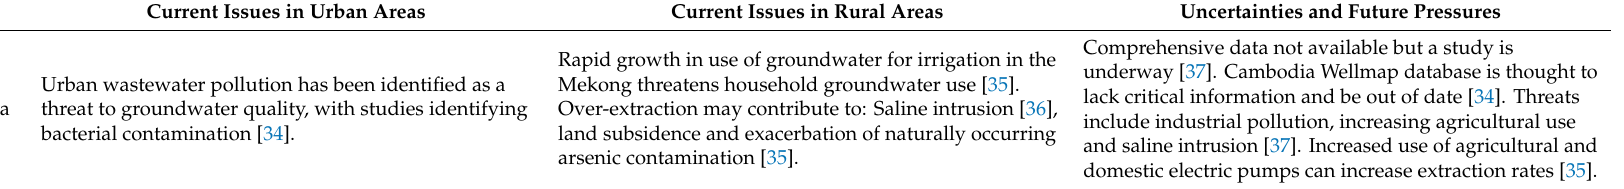
Table 2. Synthesis of literature on groundwater resource concerns in case study